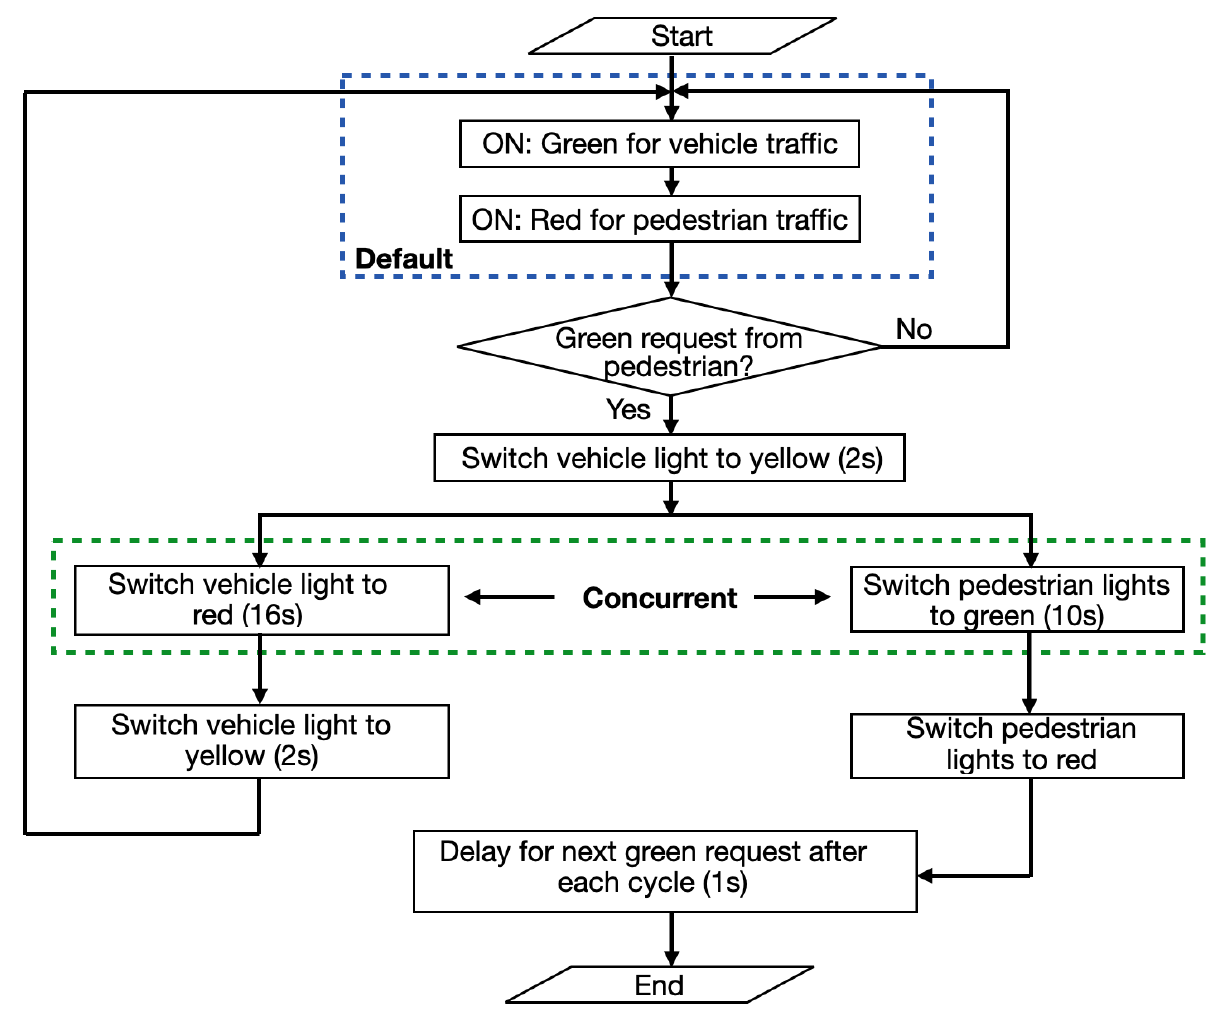
Figure 2. Flow chart of TLIGHT system operations.